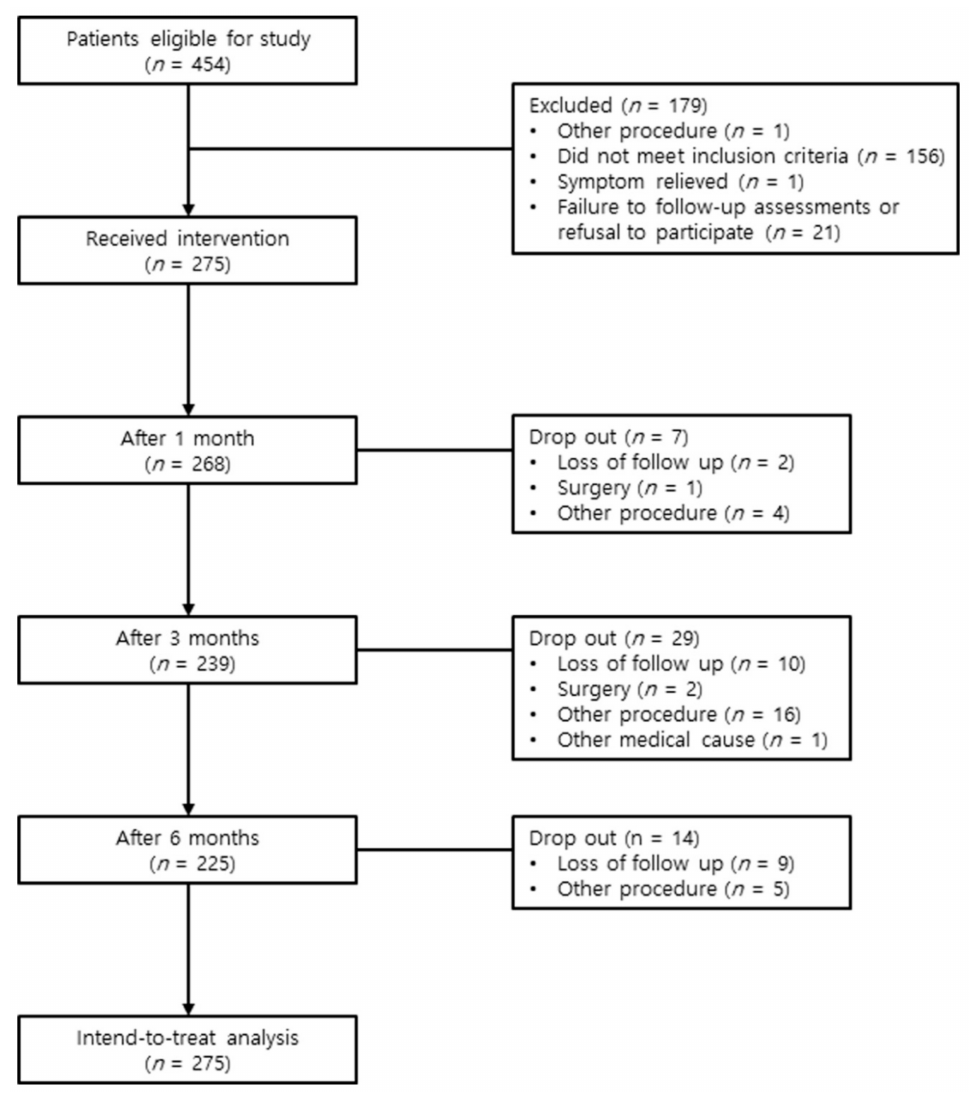
Figure 2. Study flow